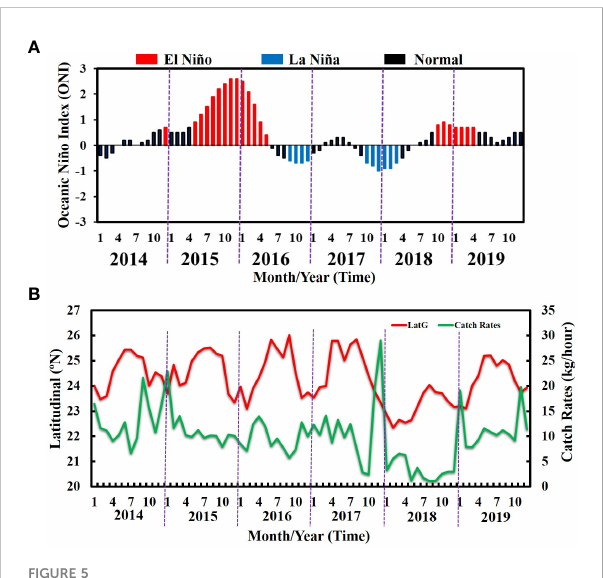
FIGURE 5 (A) Interannual variability of the El Niño – Southern Oscillation and (B) relationship between latitudinal gravitational centers and catch rates in the Taiwan Strait in 2014 – 2019.